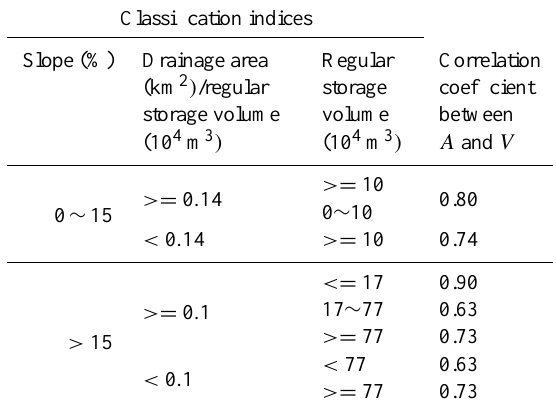
Table 2. Classification of water storages and correlations between surface area ( A ; m 2 ) and regular storage volume ( V ; 10 4 m 3 ) of each water storage class within the basin.